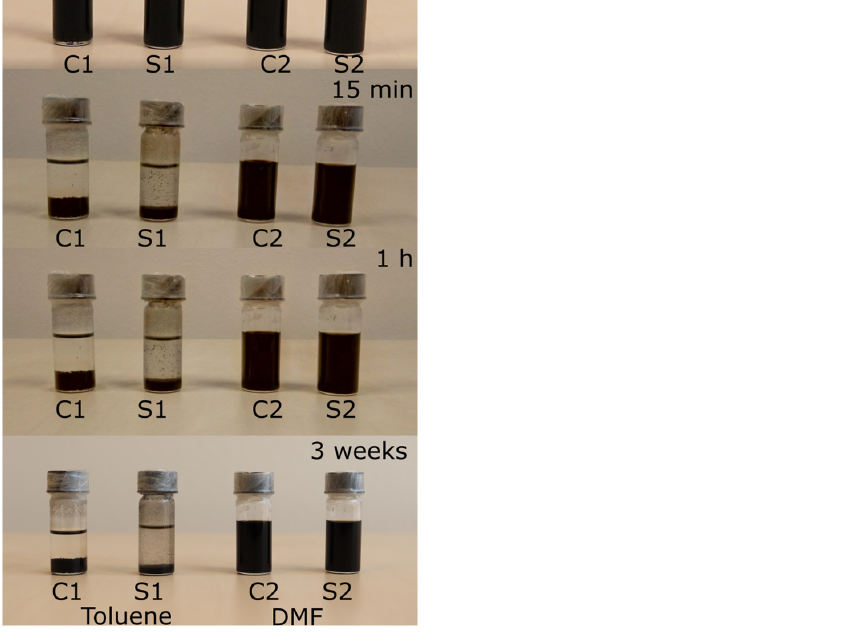
Figure 5. Photographs of carboxylated and silanized SWNTs dispersed in both toluene and DMF.